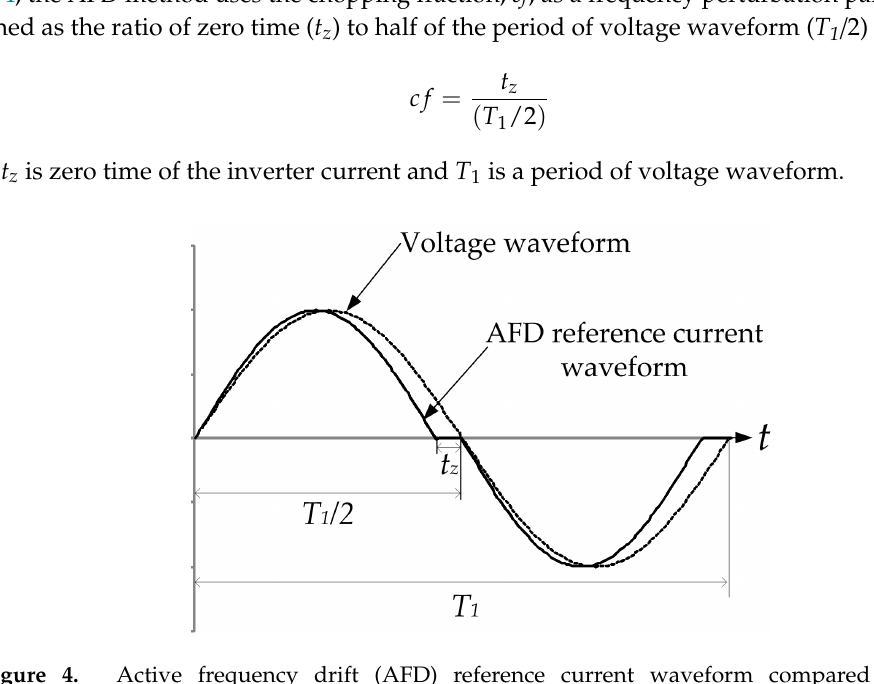
Figure 4. Active frequency drift (AFD) reference current waveform compared with the voltage waveform.